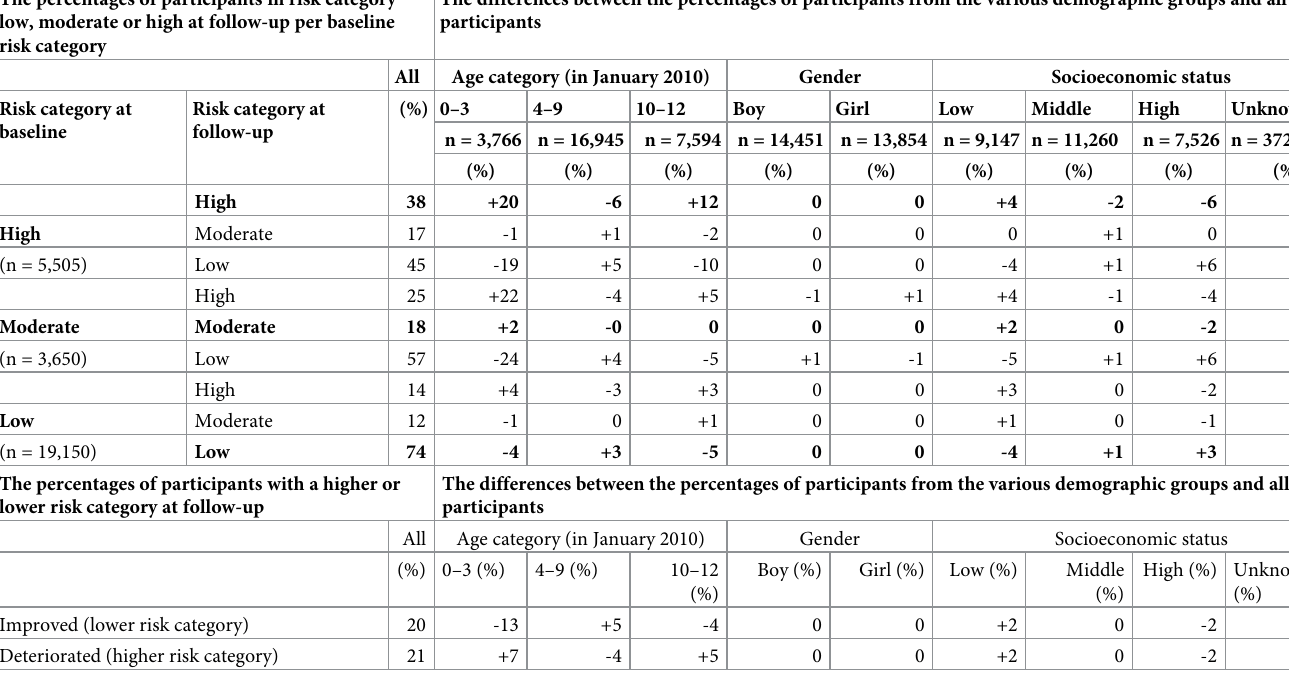
Table 7. Changes in risk categories for dental caries after 3 years of follow-up for all participants and participants from different sociodemographic groups. The percentages of participants in risk category The differences between the percentages of participants from the various demographic groups and all low, moderate or high at follow-up per baseline participants risk category